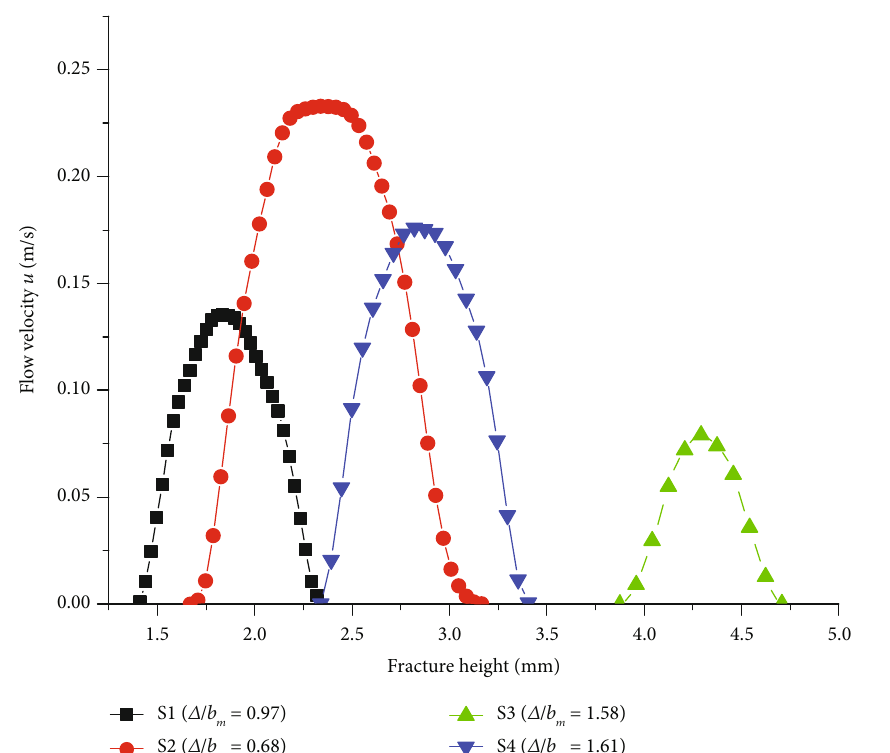
Figure 13: Velocity distribution along the fracture height ( Z direction) of specimens S1-S4 ( X = 25mm interested Y = 50 mm